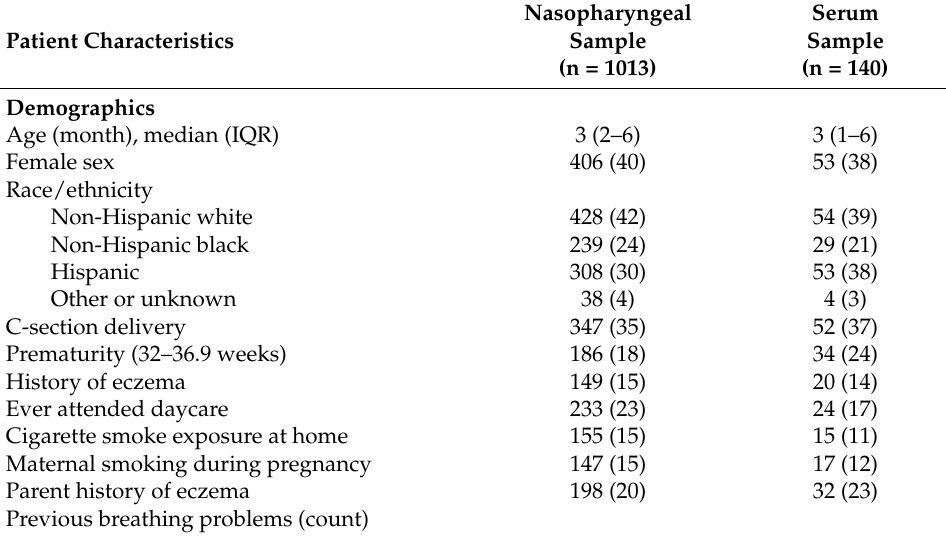
Table 1. Characteristics and clinical course of infants hospitalized for bronchiolitis, according to nasopharyngeal and serum metabolome